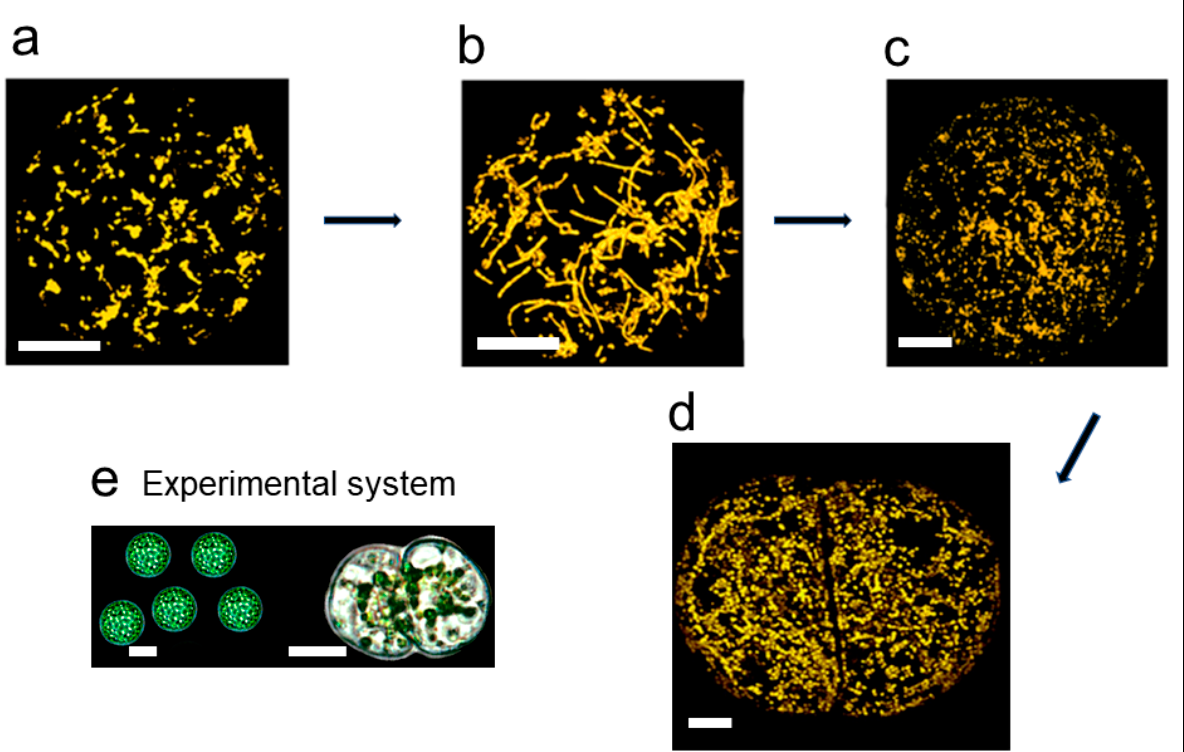
Figure 1. Mitochondrial fusion and fission prior to the first cell division in regenerating Nicotiana tabacum protoplasts. Visualised by GFP-expressing mitochondria. ( a ) Mitochondria in freshly isolated protoplasts are small ovoid organelles, showing some clumping. ( b ) Massive mitochondrial fusion forming highly elongated mitochondria. ( c ) After fusion, there is fission, generating large numbers of small mitochondria. ( d ) Uniformly dispersed mitochondria enable unbiased inheritance at cell division. ( e ) The experimental system. Dividing protoplast shows clustering of chloroplasts around the nucleus. Bars ( a – d ) 10 µm, Bars ( e ) = 20 µm. Figure 1 taken from [1] the Yale Journal of Biology and Medicine under Creative Commons Attribution-NonCommercial-ShareAlike 3.0.